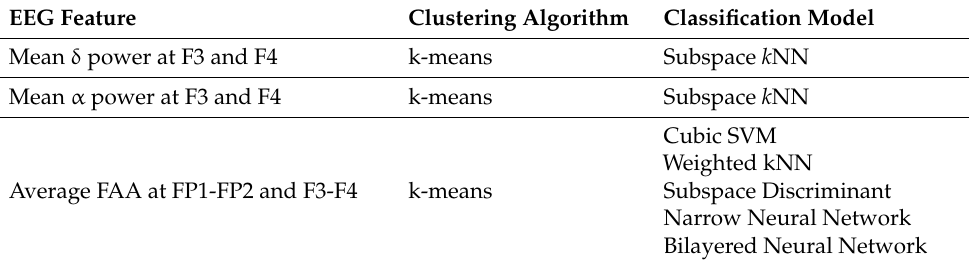
Table 9. The proposed combinations to cluster the situational interest in classroom